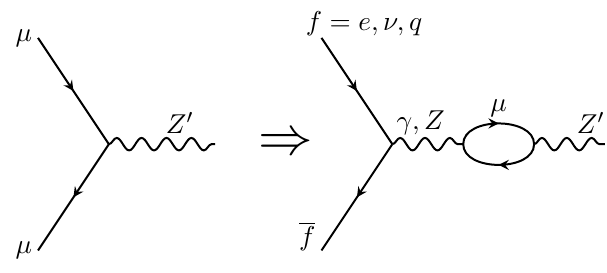
Figure 1 . The loop diagram from which the presence of the Z 0 - µ - µ coupling generally implies the existence of Z 0 couplings to other